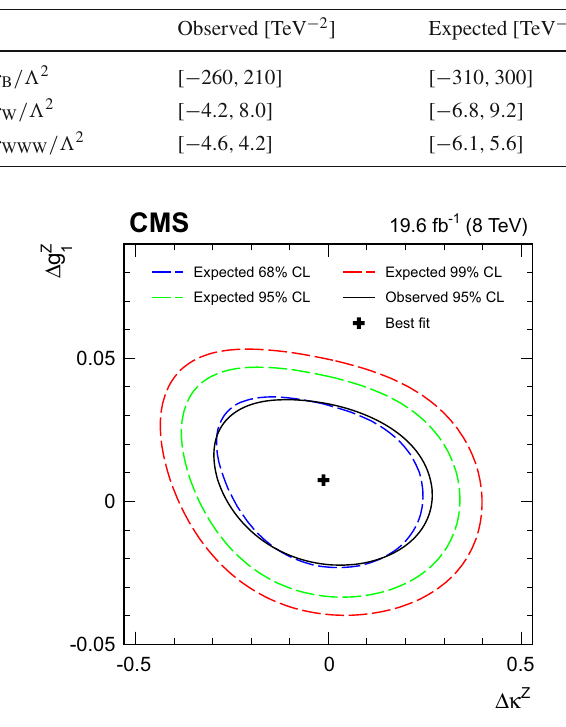
Fig. 8 Two-dimensional observed 95% CL limits and expected 68, 95 and 99% CL limits on anomalous coupling parameters (cid:7)κ Z and (cid:7) g Z